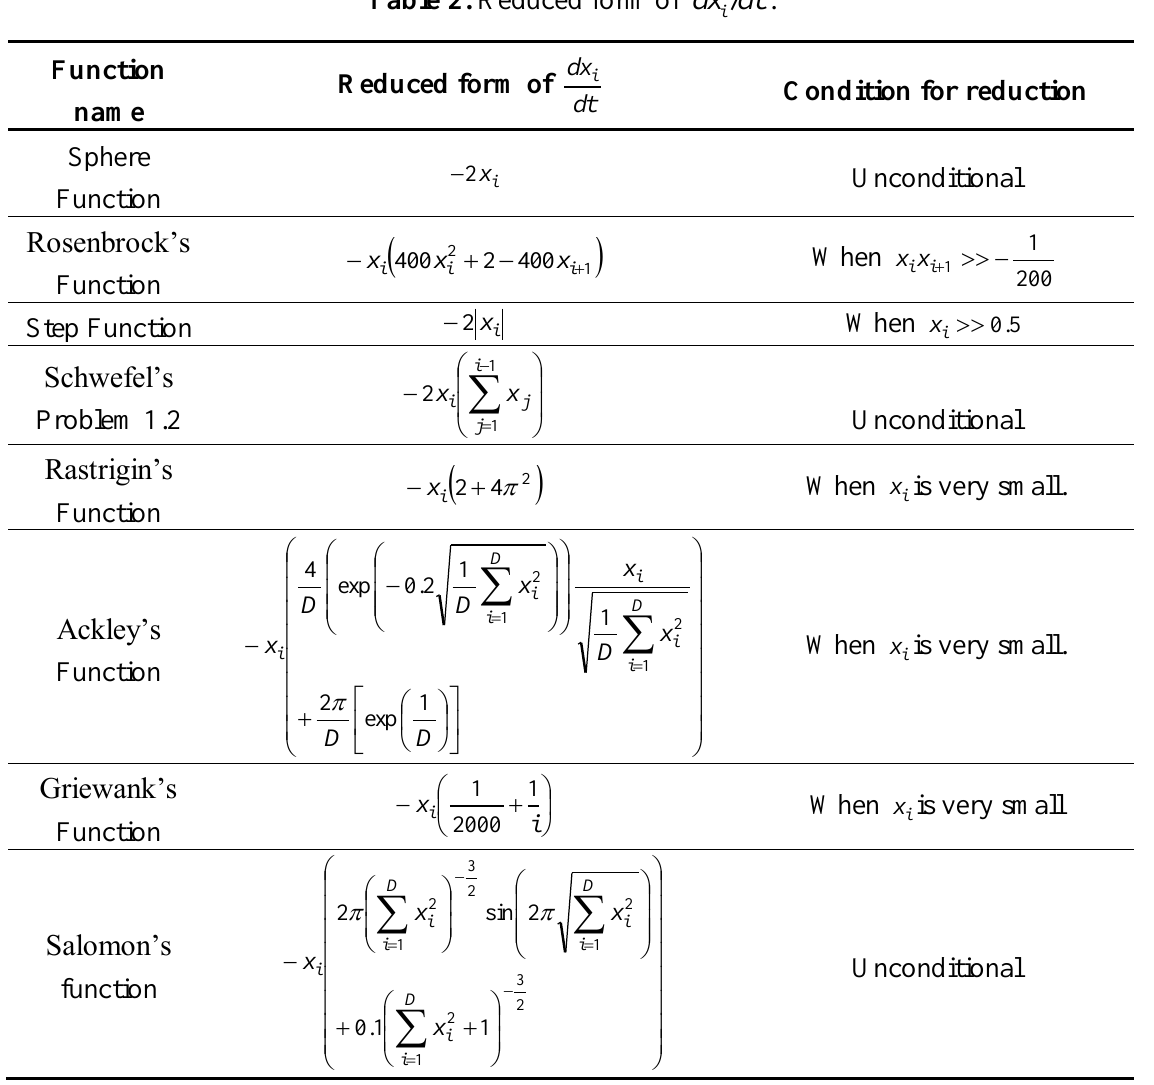
Table 2. Reduced form of /